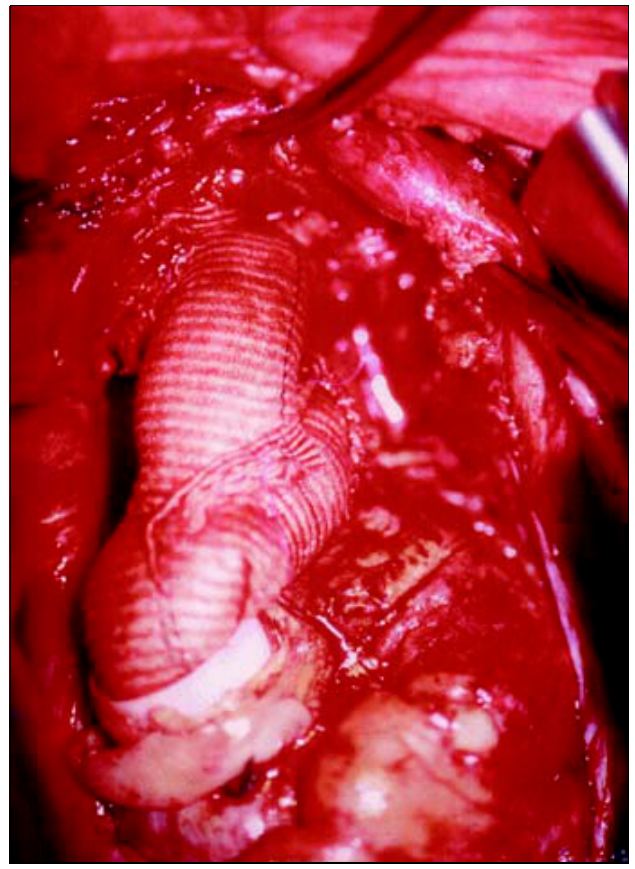
Fig. 1 - Corre(cid:231)ªo de dissec(cid:231)ªo aguda de aorta com abordagem de arco